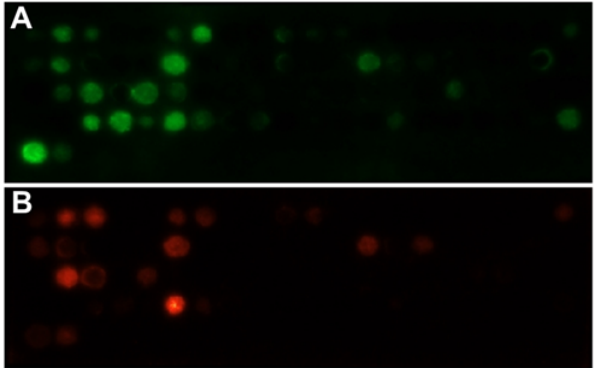
Figure 1. DnaK binding to immobilised peptides attached to a cellulose-based membrane. A) Group 2 peptides Membrane A, B) Group 2 peptides Membrane A bound to antibody only, indicating potential false positives (see supplementary Table 1 for all groups of peptide sequences and raw binding data).